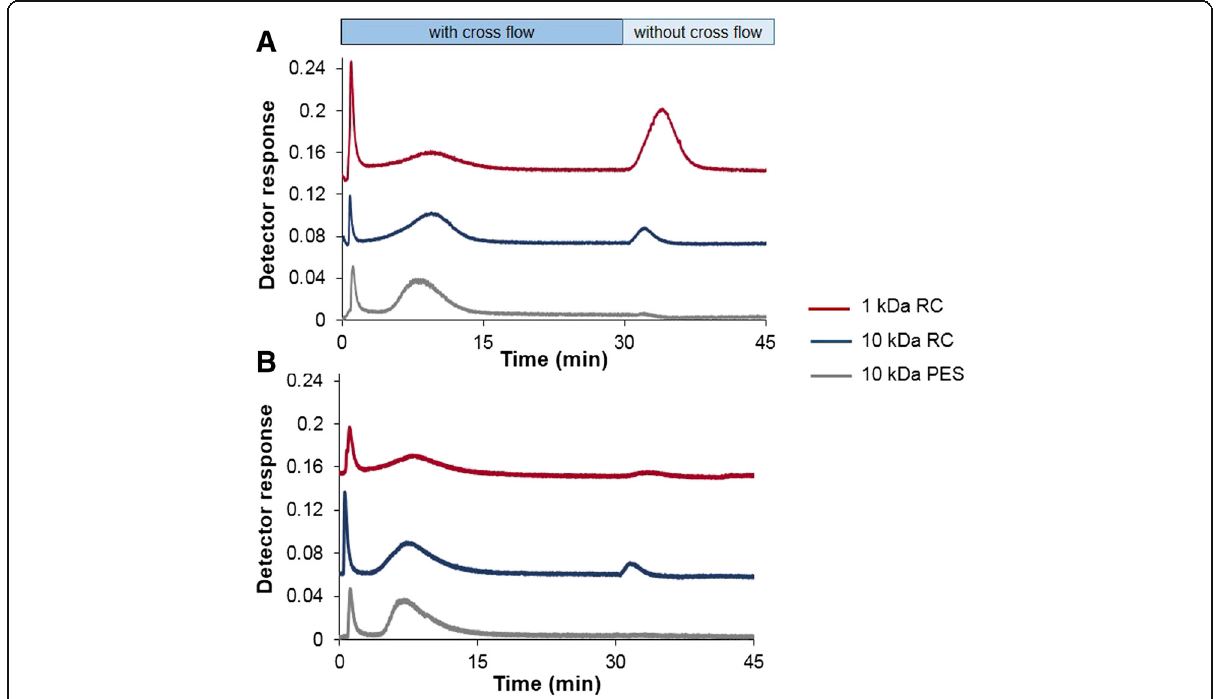
Fig. 1 Comparison of peak appearance of 100 nm silica nanoparticles with various membranes: 1 kDa RC shown by red line, 10 kDa RC shown by blue line, and 10 kDa PES shown by gray line. Different carrier solutions were introduced: a 0.02% FL-70 with 0.02% NaN 3 and b 0.25